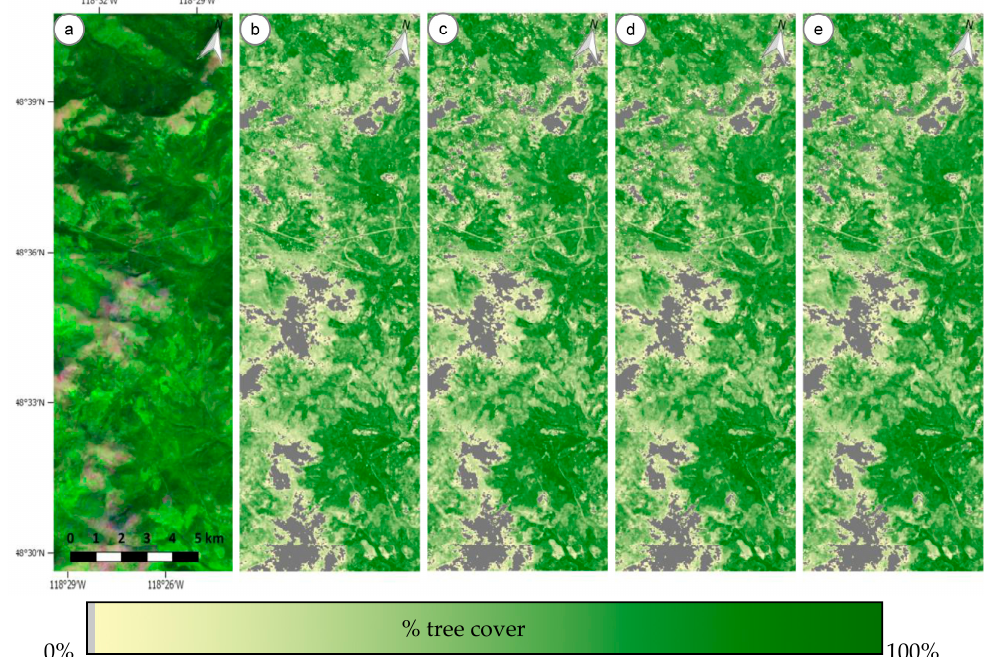
Figure 5. Detailed 7 × 21 km subset centered at 48°35 ′ 49.48 ″ N, 118°28 ′ 8.25 ″ W (Sherman Peak and surroundings, WA) of ( a ) the 5-year median of the Landsat 5 TM and Landsat 7 ETM+ band 5 (red), 4 (green), 3 (blue) atmospherically corrected ARD metrics (from Figure 1), mapped percent tree cover 30 m derived using 8% training per tree and 50 multi-temporal metrics extracted from ( b ) top of atmosphere ARD (TOA ARD); ( c ) atmospherically corrected ARD (SRF ARD); ( d ) BRDF adjusted atmospherically corrected ARD (NBAR SRF ARD); and ( e ) weekly composited BRDF adjusted atmospherically corrected ARD (NBAR SRF